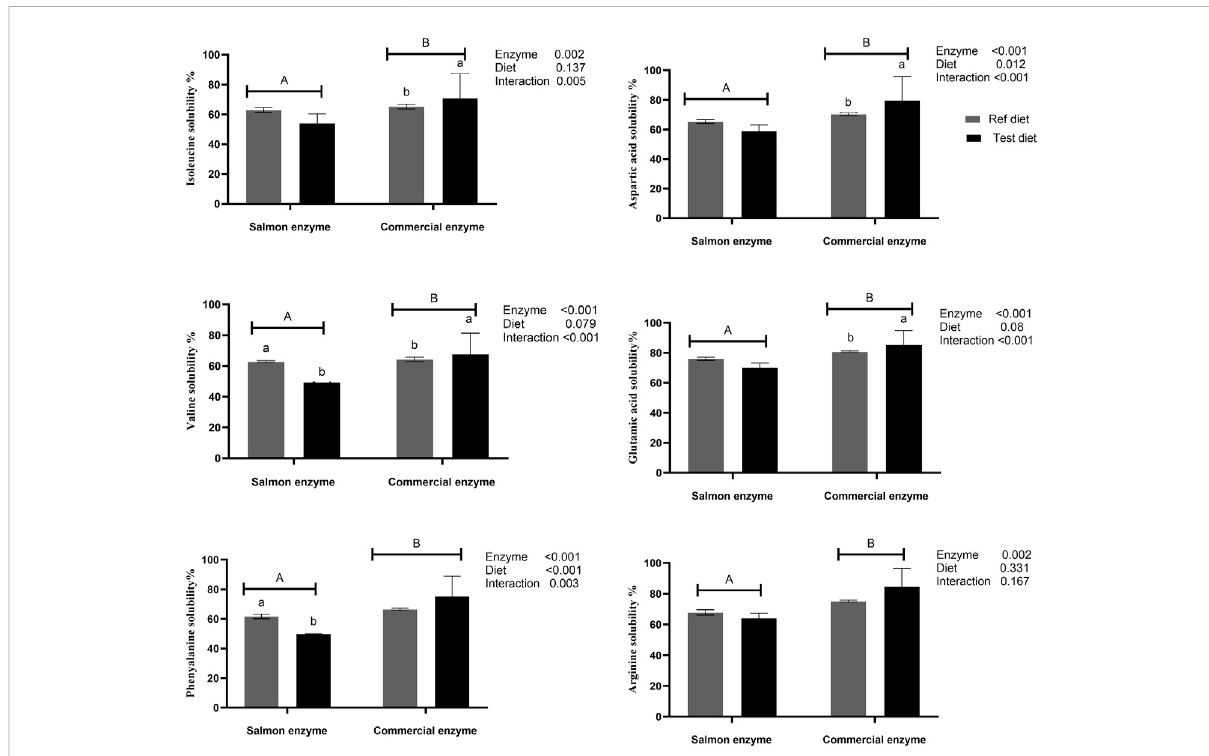
FIGURE 1 In vitro amino acids solubility of reference and test diets using salmon and commercial enzyme. Values are means of 2 values, with their standard deviation represented by vertical bars. Capital letters (A,B) indicate statistical difference between salmon enzyme and commercial enzyme detected with two-way ANOVA followed by Tukey ’ s multiple comparisons. Small letters (a,b) indicate the statistical difference between diets detected with one-way ANOVA. In vitro solubility values of the reference and test diets for remaining amino acids are presented in Supplementary Table